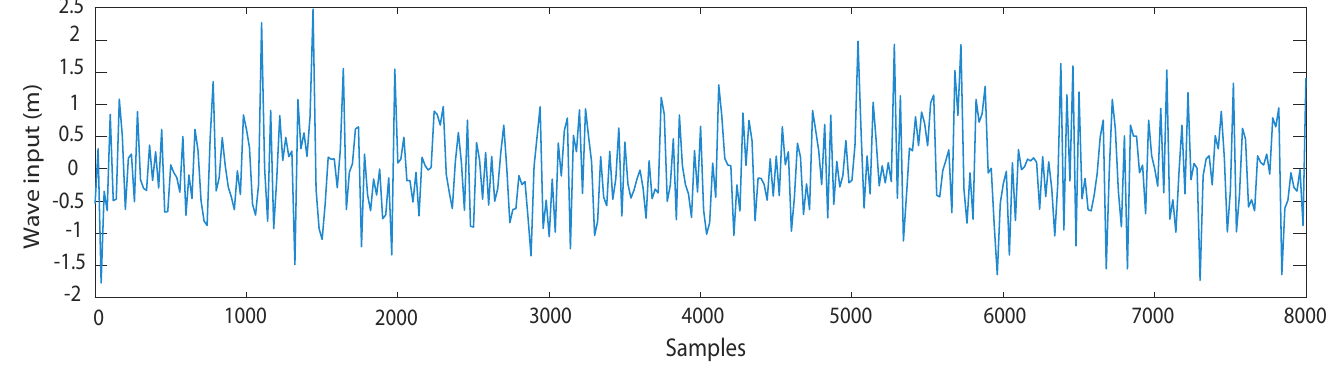
Figure 4. Wave input as